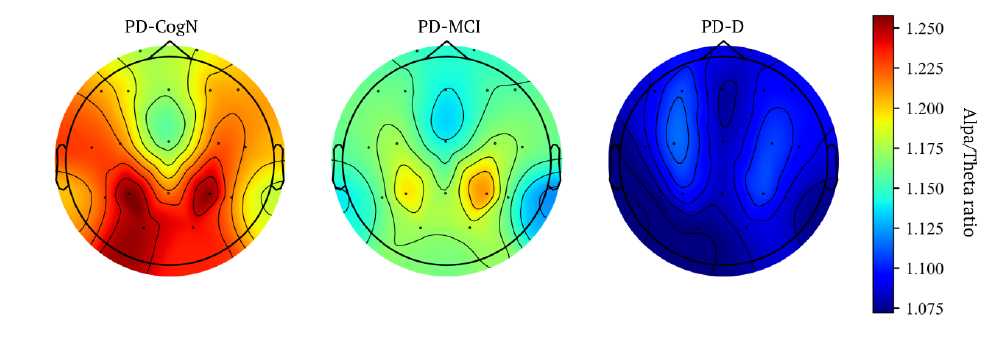
Figure 6. Average topographic maps of Alpha/Theta ratio in patient’s groups.